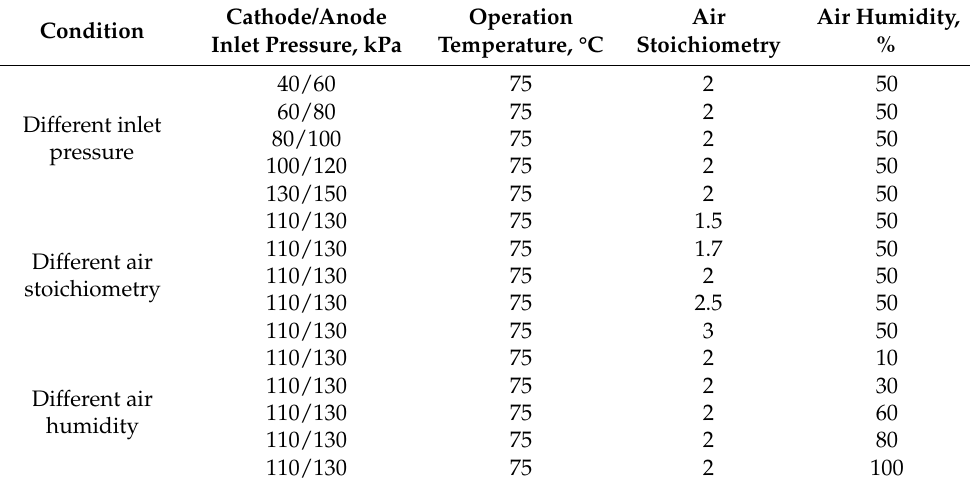
Table 1. The working conditions of the